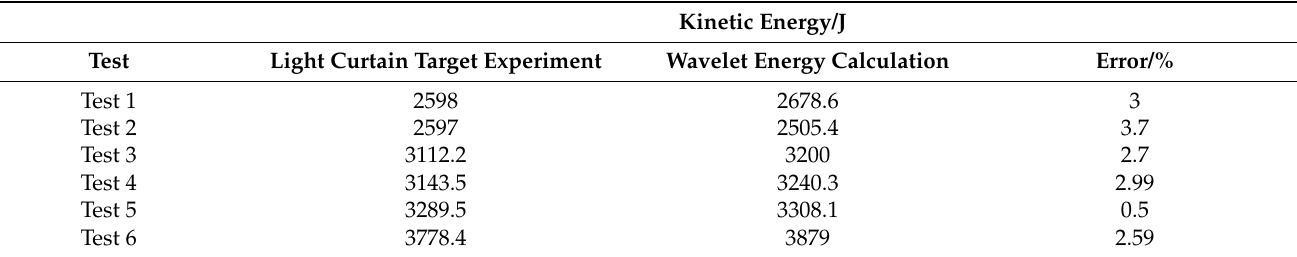
Table 5. Light curtain target speed and target results compared with